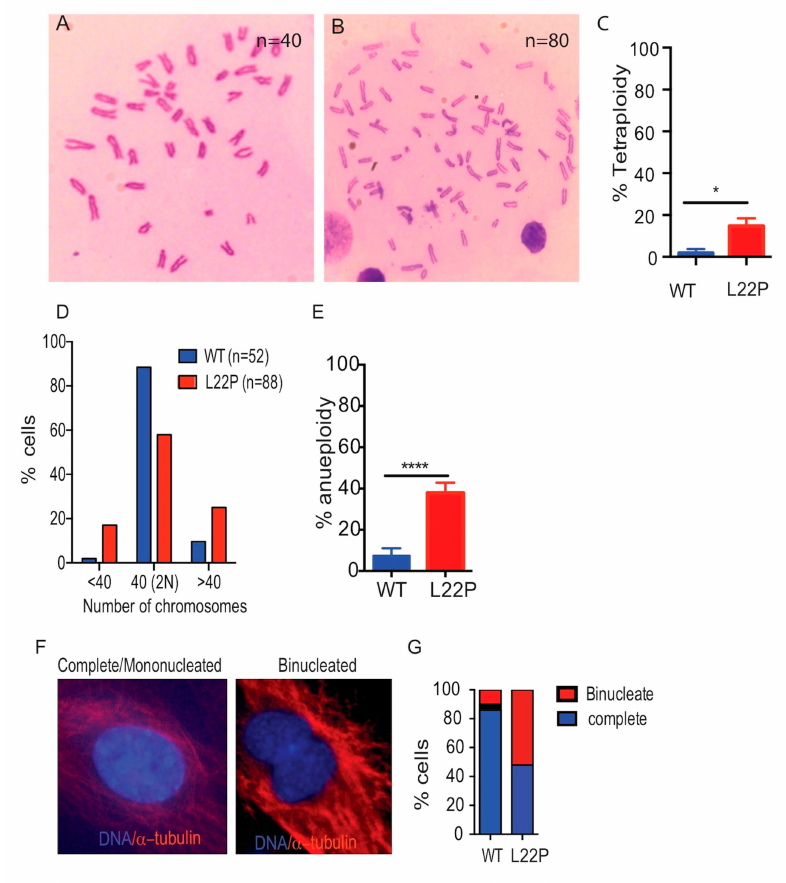
Figure 4. L22P cells cause abnormal number of chromosomes. ( A ) Representative image of diploid mouse embryonic fibroblast (MEF) chromosome spread with 40 chromosomes; ( B ) Tetraploid L22P MEFs cells chromosome spread with 80 chromosomes, All metaphase chromosome spread image were captured using 40 × objective with bright field microscope; ( C ) Percent of tetraploid MEFs; ( D ) Histogram of chromosome spreads to show the spread of aneuploidy; ( E ) Average aneuploidy in MEFs (3 experiments of 50 spreads each; ( F ) The image of cytokinesis during cell division in WT and L22P cells indicates mononucleated versus binucleated cells, respectively. All image captured wit 63x objective of Zeiss fluorescence microscope (Zeiss, San Diego, CA, USA); ( G ) Percent of cells with binucleate formation, cells that fail to complete cytokinesis, and cells with complete cytokinesis for WT ( n = 137) and L22P ( n = 65) cells. All statistical analyses were carried out with Student’s t -test, and statistical significance is designated by * p < 0.05; **** p < 0.0001. All data were analyzed